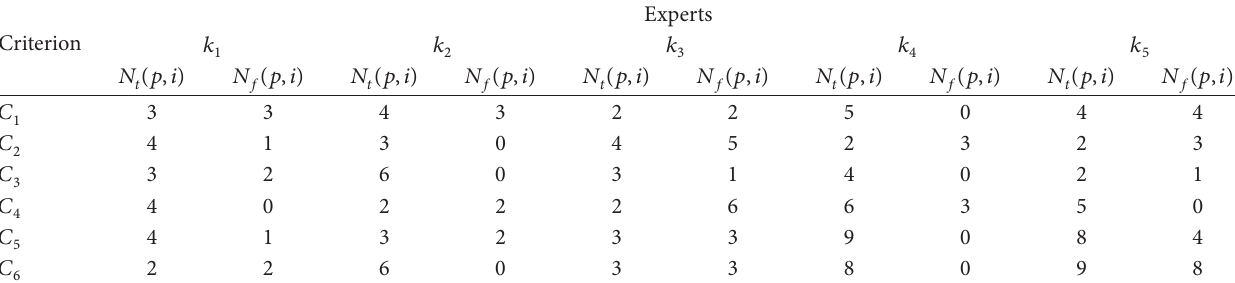
Table 4: Mutual history of the experts with respect to each criterion.